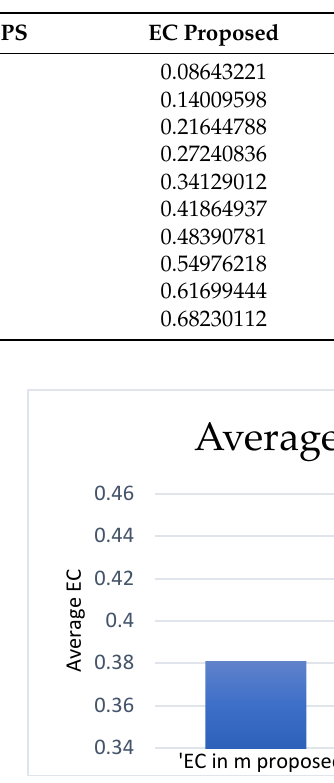
Figure 4. Average Energy Consumption.